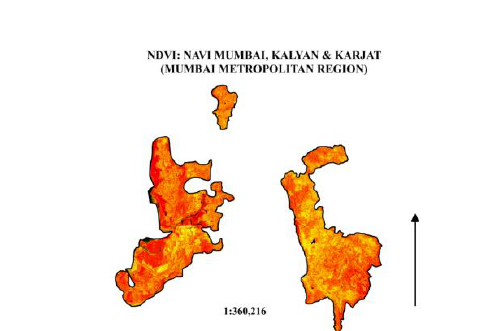
Figure 3 : NDVI for Navi Mumbai, Kalyan and Karjat Source : Landsat 8, May 2018